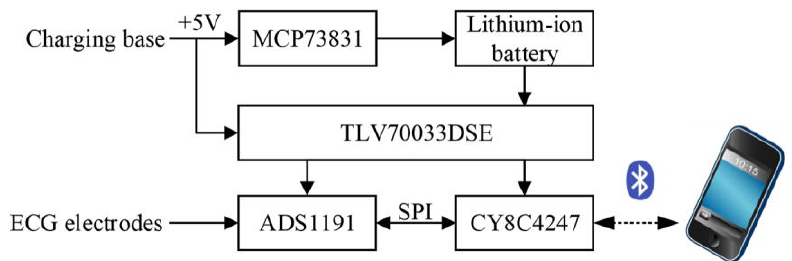
Figure 3. Block diagram of the hardware of the ECG patch.